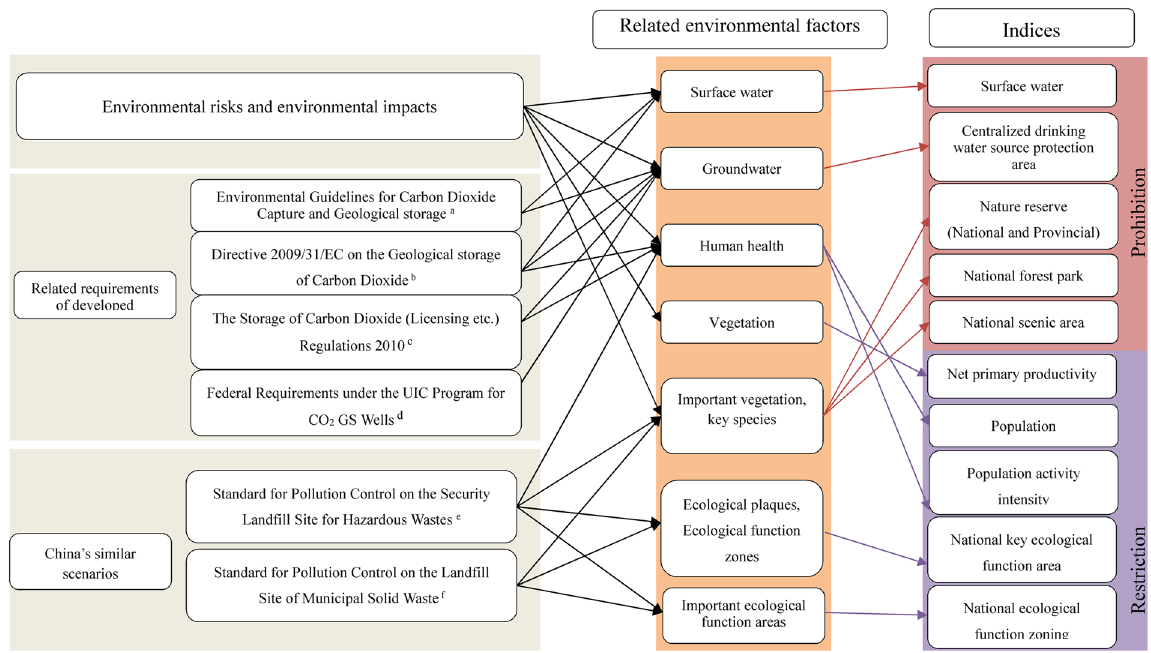
Figure 1. Factors and indices related to the environmental risks and effects of CO 2 capture and storage. Note for Fig. 1: a The Australian Environment Protection and Heritage Committee, Environmental Guidelines